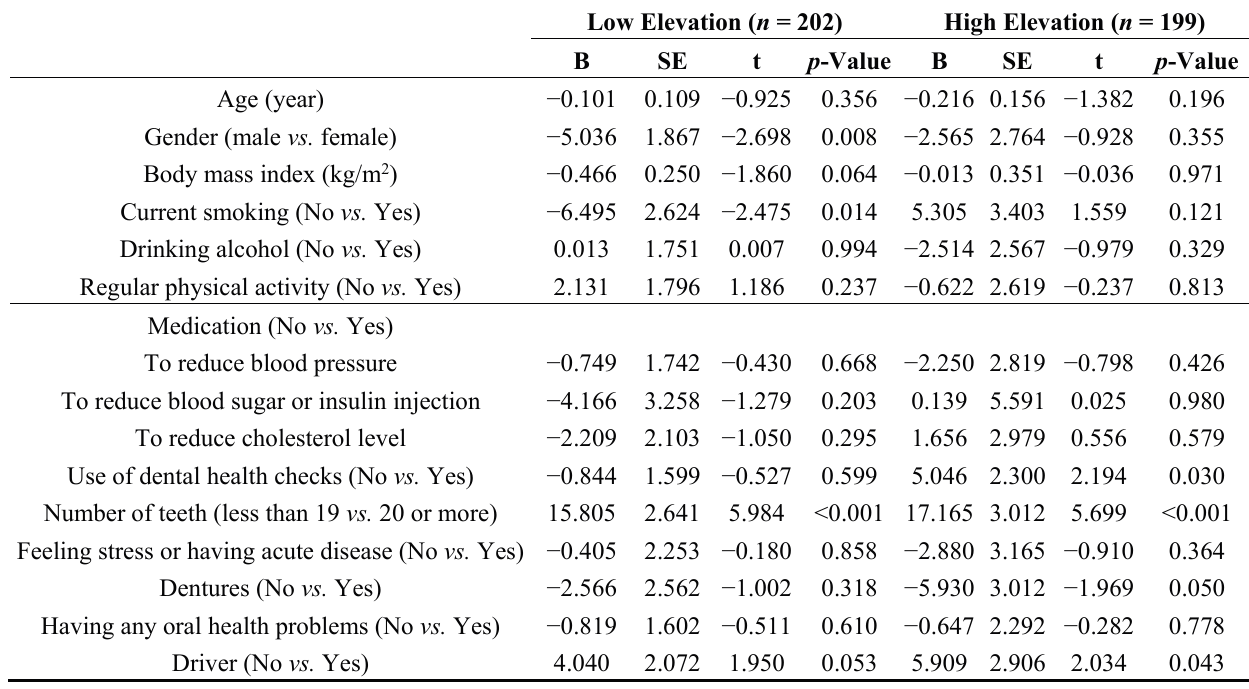
Table 4. Multivariable linear regression analysis with masticatory ability as dependent variable in Iwami